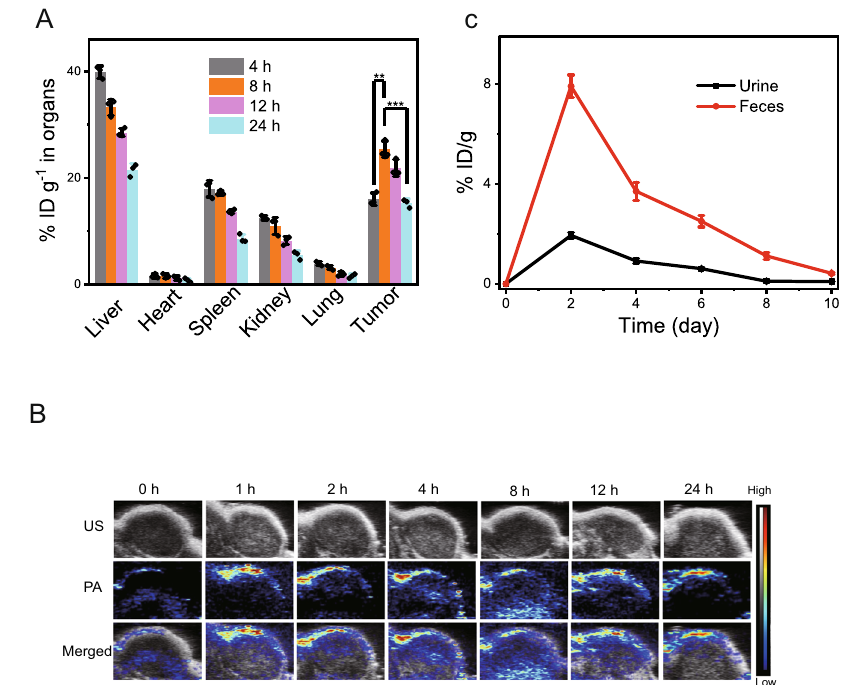
Fig. 7 Ex vivo biodistribution and in vivo PA imaging. A Ex vivo tissue distribution of RuDA-NPs in mice determined by the content of Ru (% injected dose (ID) of Ru per gram of tissues) at different post injection time. The data represent the mean ± SD ( n = 3). Unpaired, two-sided t tests * p < 0.05, ** p < 0.01, and *** p < 0.001. B In vivo PA images of tumor sites under excitation at 808 nm after intravenous injection of RuDA-NPs (10 μ mol kg − 1 ) at different time points. C Ru excreted out of the mice body via urine and feces after intravenous administration of RuDA-NPs (10 μ mol kg − 1 ) at different time intervals. The data represent the mean ± SD ( n =